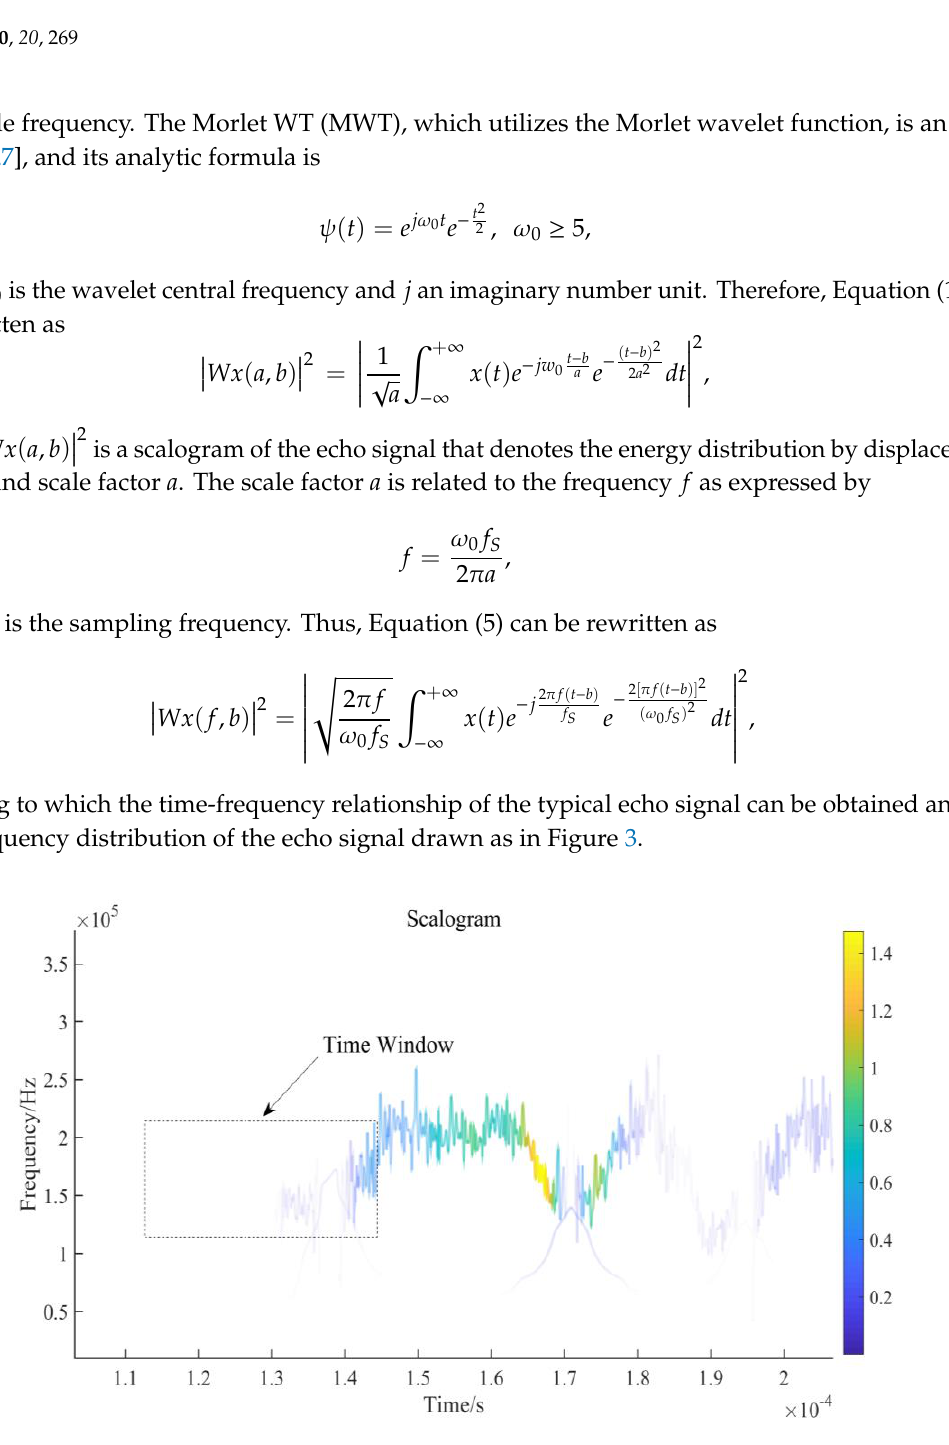
Figure 3. Time-frequency distribution based on Morlet WT (MWT).